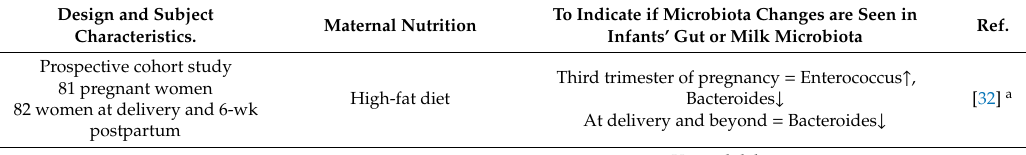
Table 1. Alterations of infant gut and / or milk microbiota associated with maternal